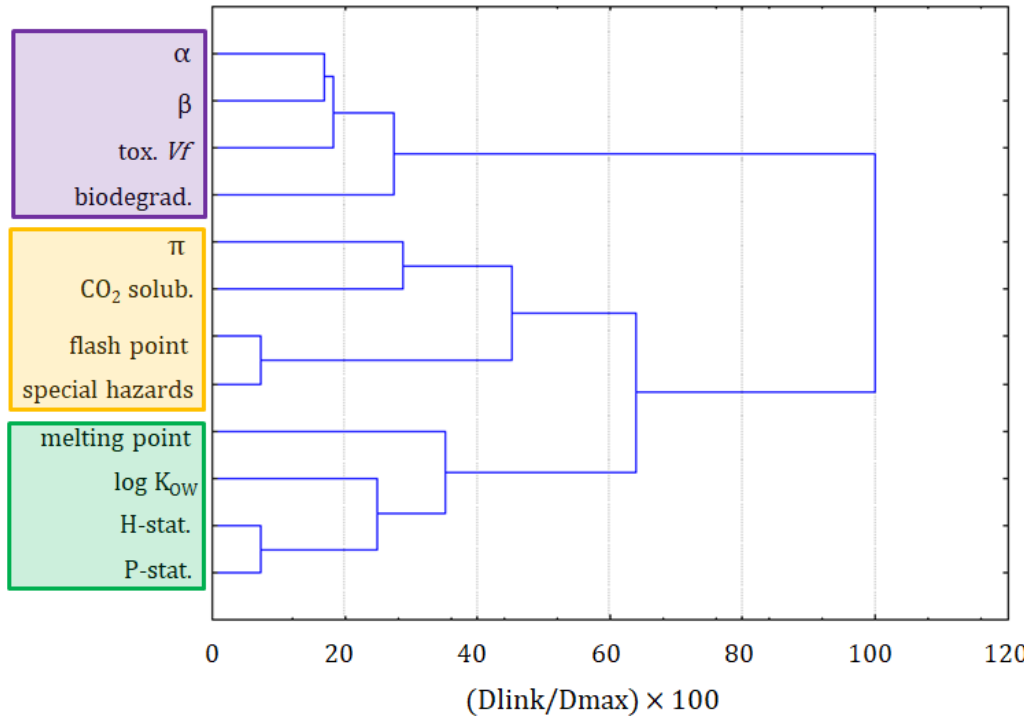
Figure 8. The hierarchical dendrogram for the clustering of 12 variables. Only the molecular solvents are included as objects.